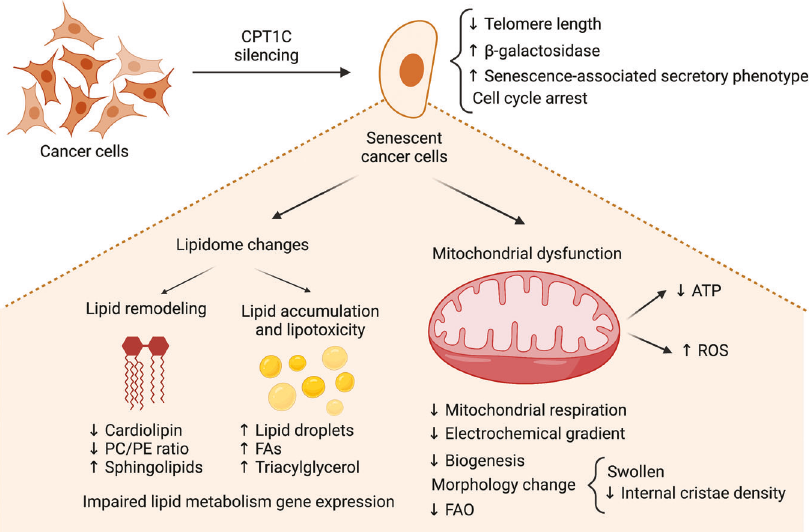
Fig. 3 Effects of CPT1C silencing in cancer cell metabolism. Downregulation of CPT1C favors cancer cell senescence, as demonstrated by the increased b-galactosidase marker, diminished telomere length, cell cycle arrest, and activation of the senescence-associated secretory phenotype. CPT1C downregulation, as revealed by lipidomic analysis, results in great lipid remodeling, including impaired expression of lipid metabolic genes, decreased cardiolipin levels, diminished phosphatidylcholine/phosphatidylethanolamine (PC/PE) ratio, increased levels of FAs, triacylglycerol, and sphingolipids, and lipid droplet accumulation. CPT1C downregulation impairs mitochondrial morphology, function (decreased mitochondrial respiration, decreased FAO, and altered electrochemical gradient) and biogenesis. All those changes result in decreased ATP levels and oxidative